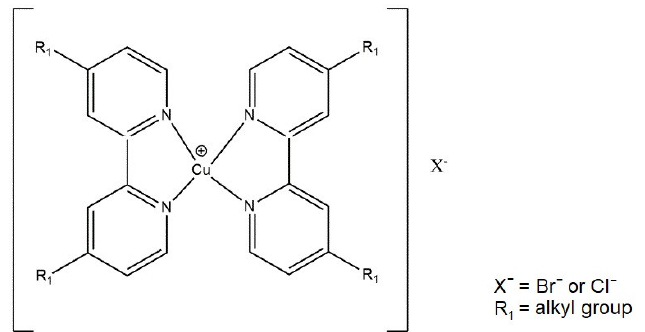
Figure 13. An example of a copper complex used as a catalyst in atom transfer radical polymerization.